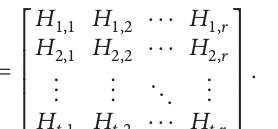
channel parameters such as angular and delay parameters have also been characterised based on ray-tracing